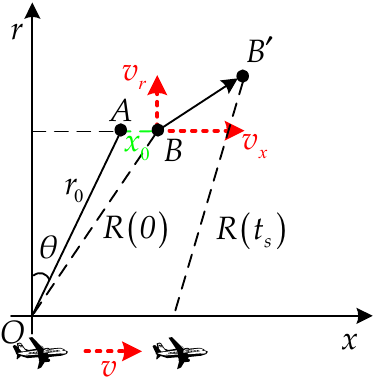
Figure 1. 2-D geometry model of SAR GMTIm with squint angle.